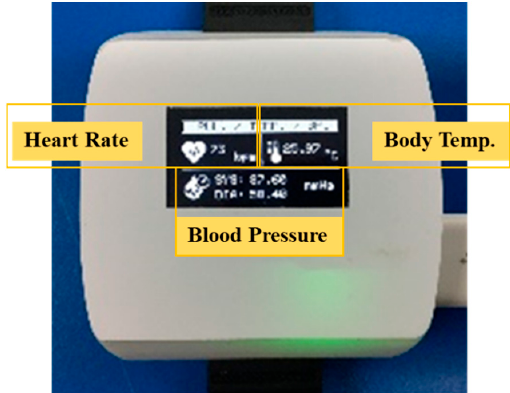
Figure 12. Smart device monitoring on OLED.